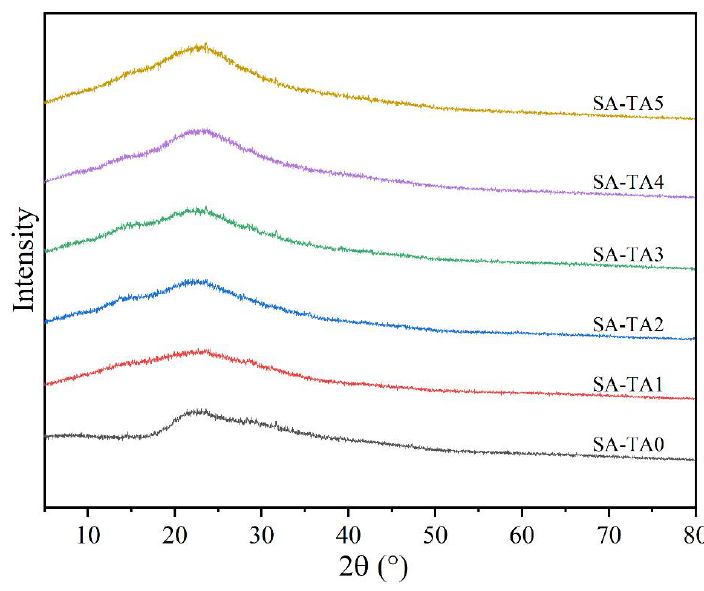
Figure 7. XRD pattern of SA and SA-TA films.